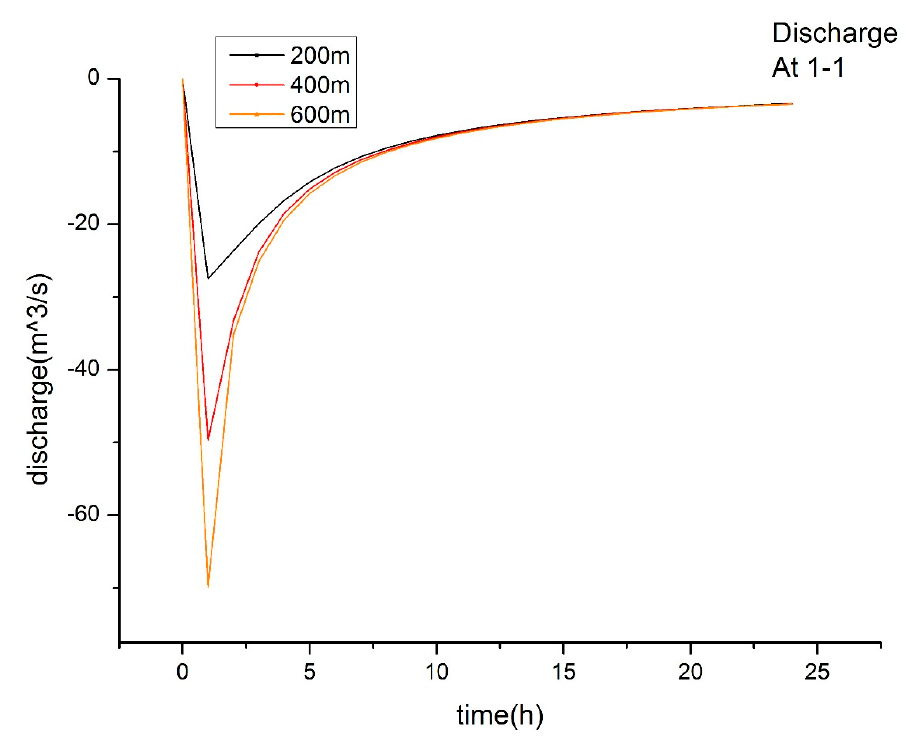
Figure 5. Simple bifurcation with different cross − section spacing.